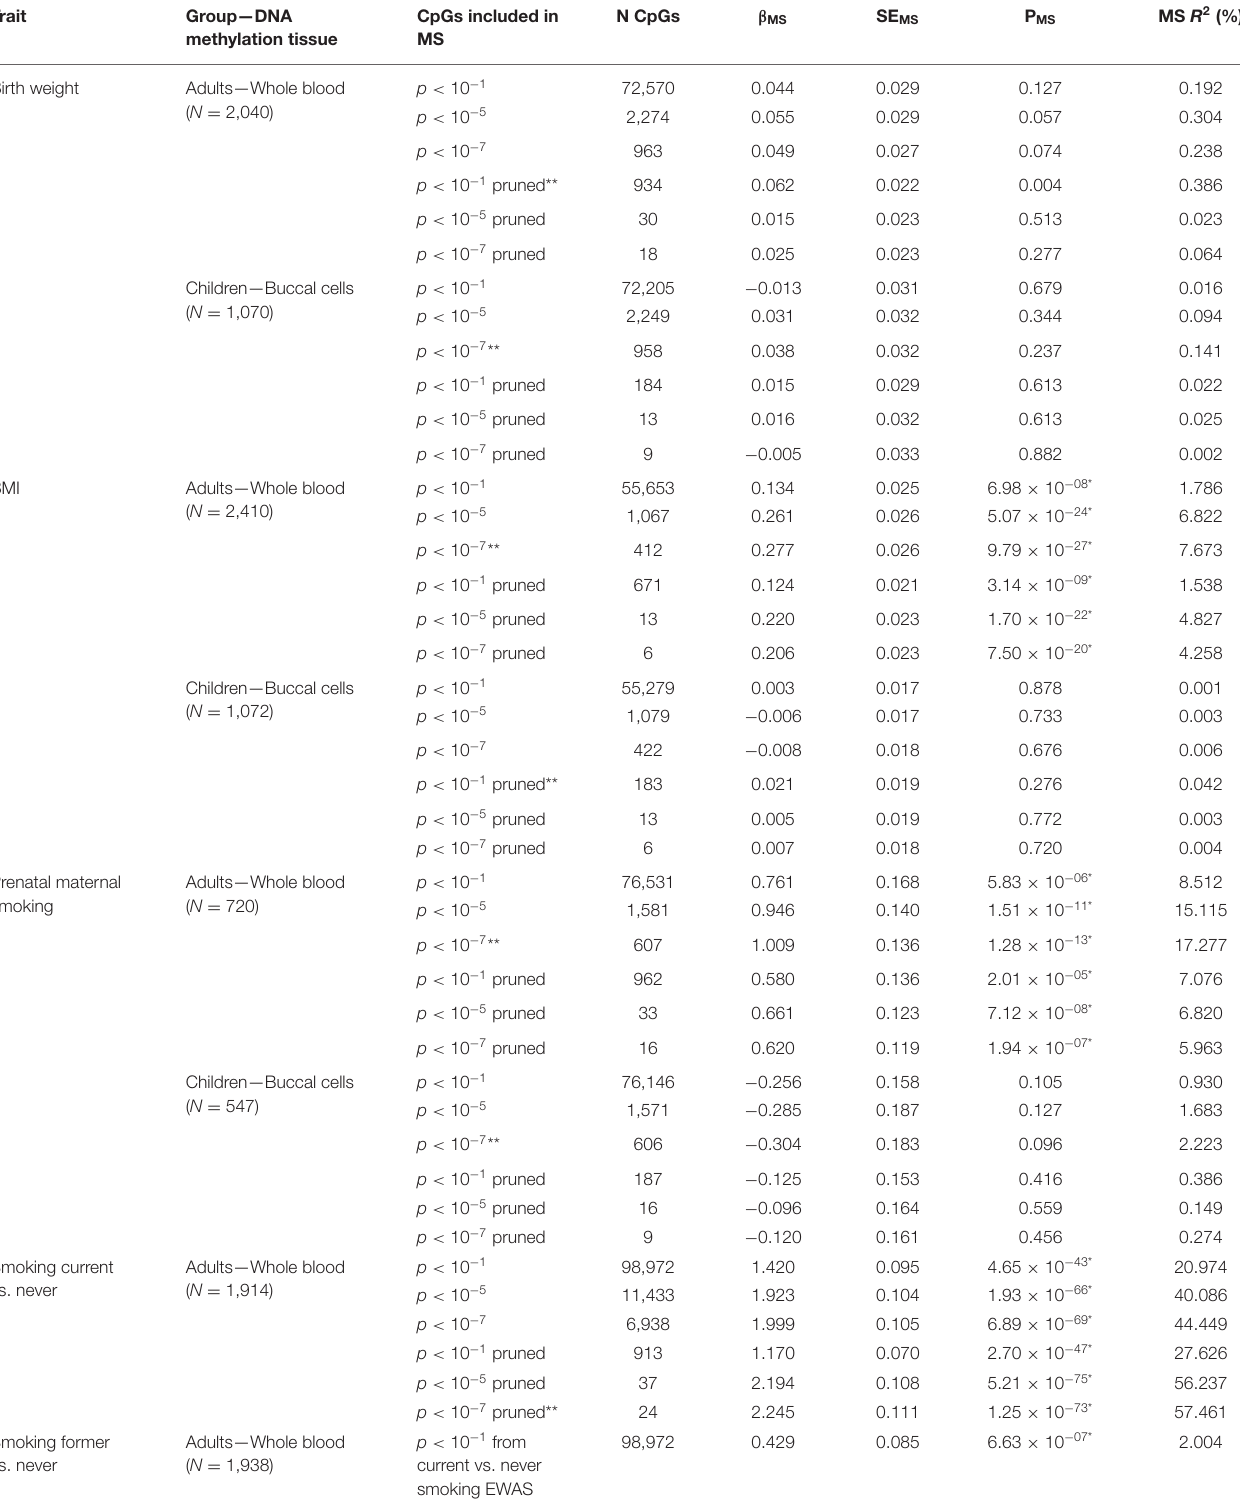
TABLE 3 | Results of the methylation score prediction of birth weight, BMI, prenatal maternal smoking and current and former smoking. Trait Group—DNA methylation